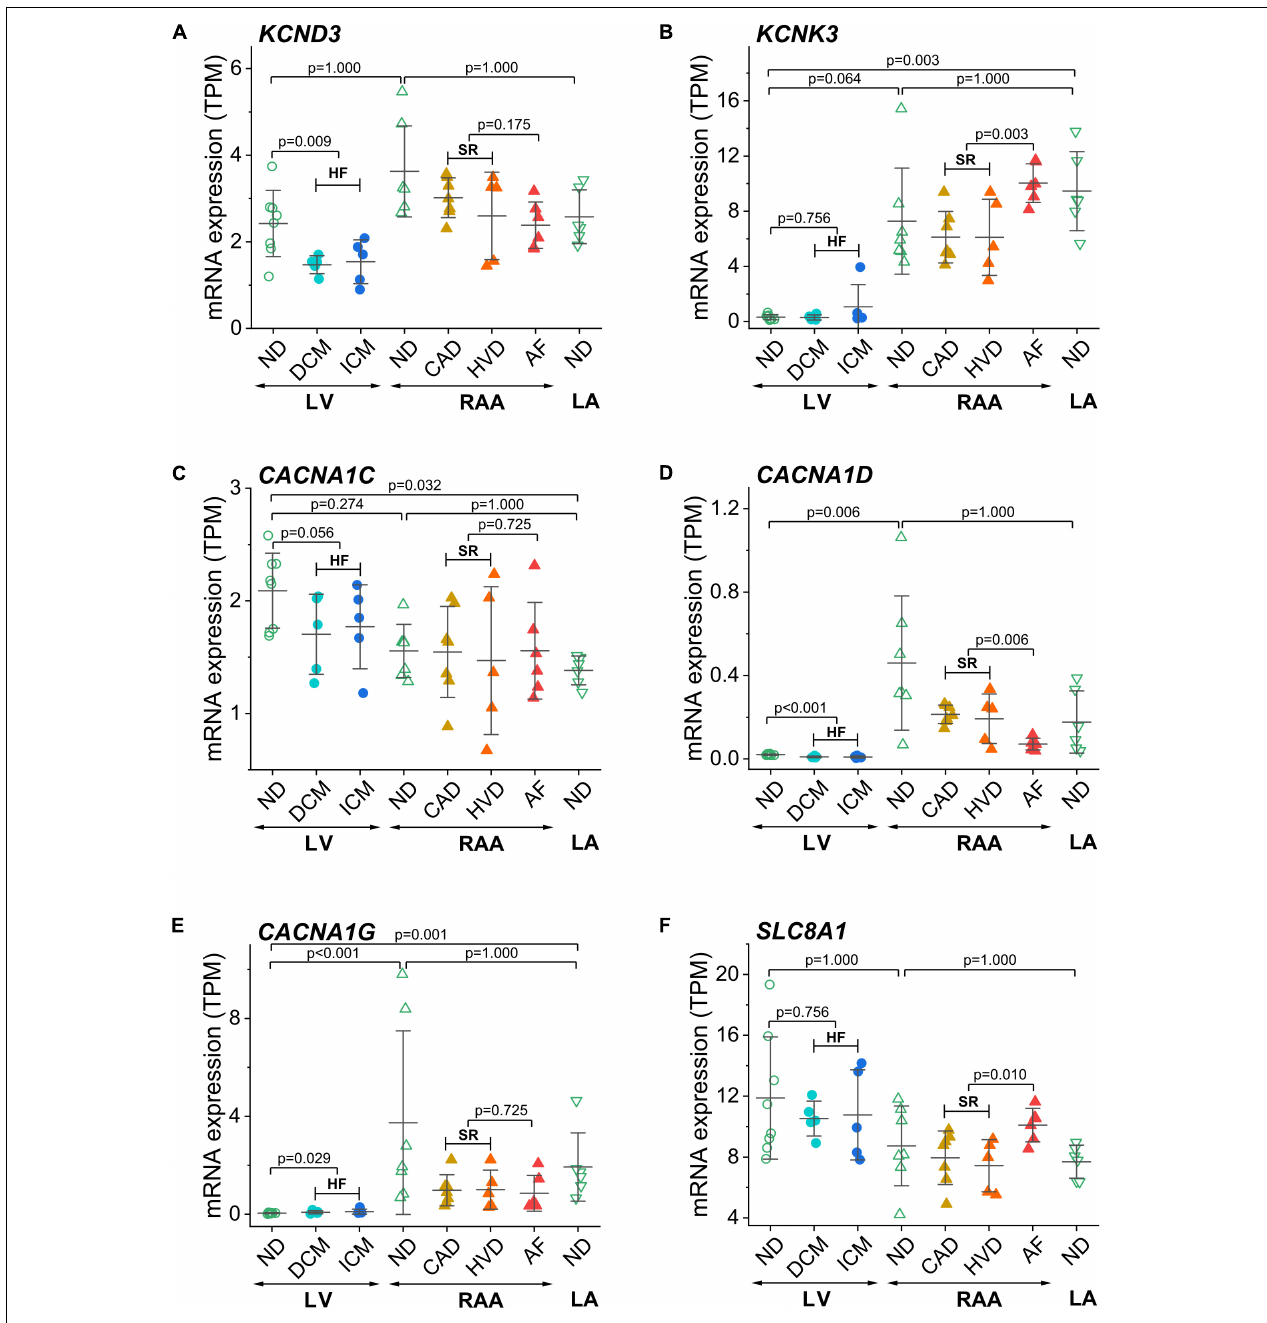
FIGURE 4 | Expression of ion channel encoding genes previously related to AF or HF in transcripts per kilobase million (TPM) assessed by RNA-seq. (A) KCND3 (K v 4.3), (B) KCNK3 (TASK-1 or TWIK-related acid-sensitive K + channel 1), (C) CACNA1C (Ca v 1.2 or Ca 2 + channel, voltage-dependent, L-type, a1C subunit), (D) CACNA1D